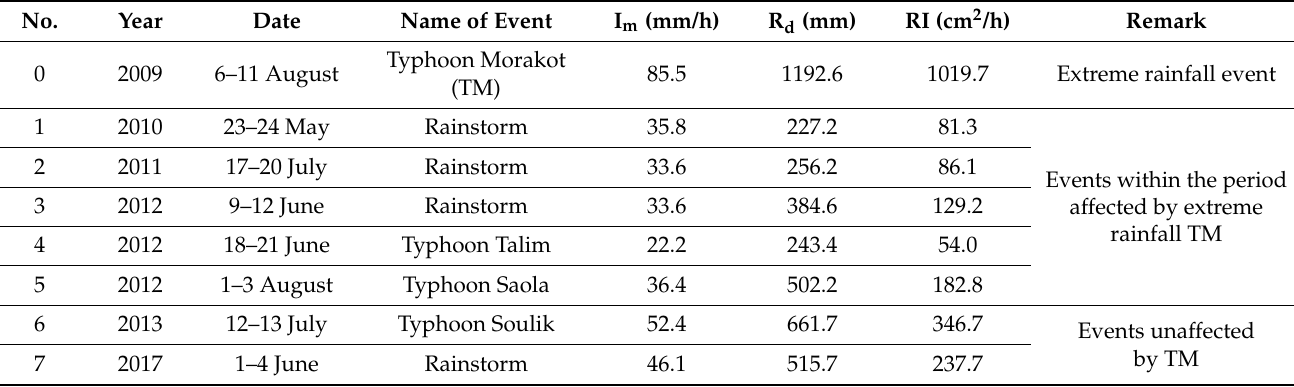
Table 3. Debris flow event and related rainfall characteristics in the Chenyulan watershed between 2009–2020, after the extreme rainfall events of Typhoon Morakot